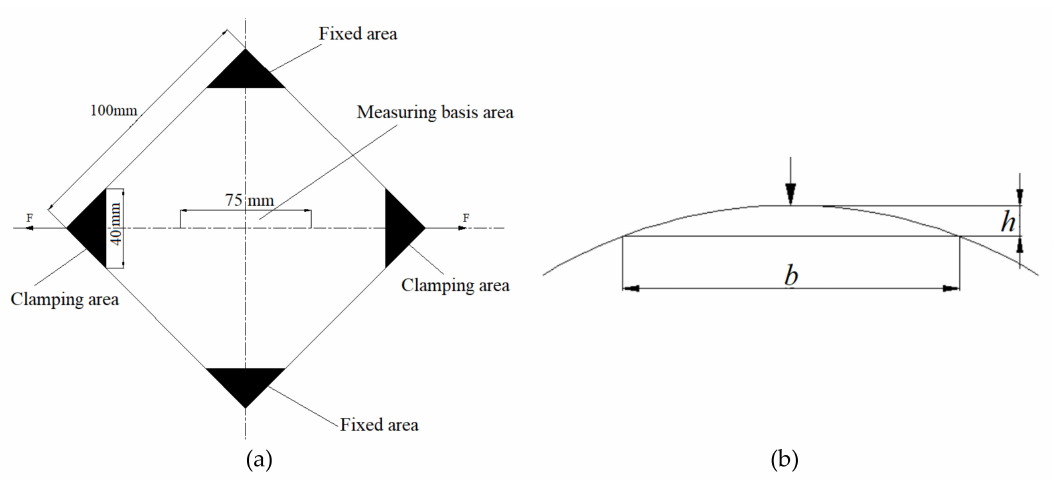
Figure 3. Schematic diagram of the wrinkling test. ( a ) Principle of the wrinkling test. ( b ) Basis of